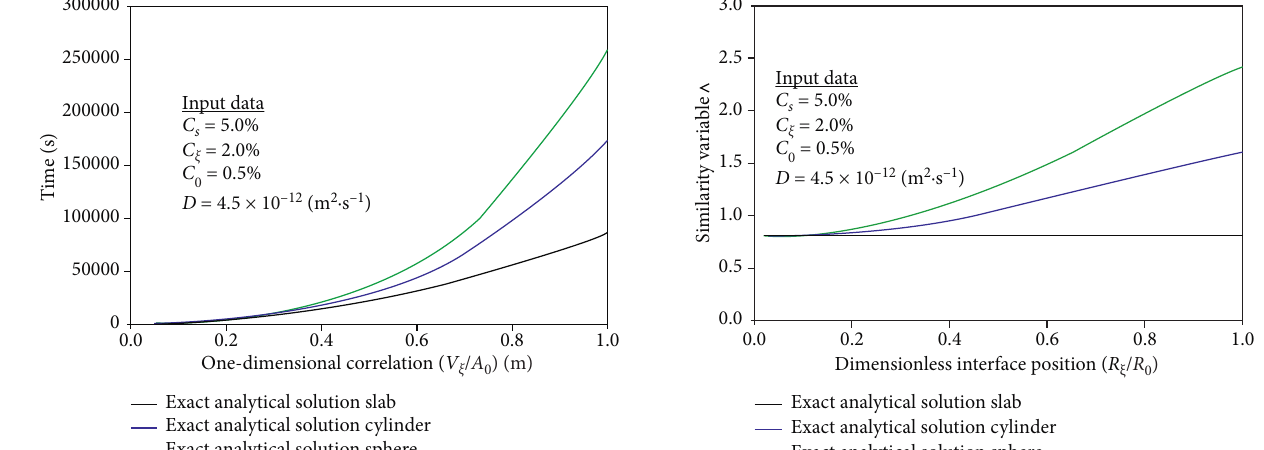
/ R during inward ξ 0 . 0